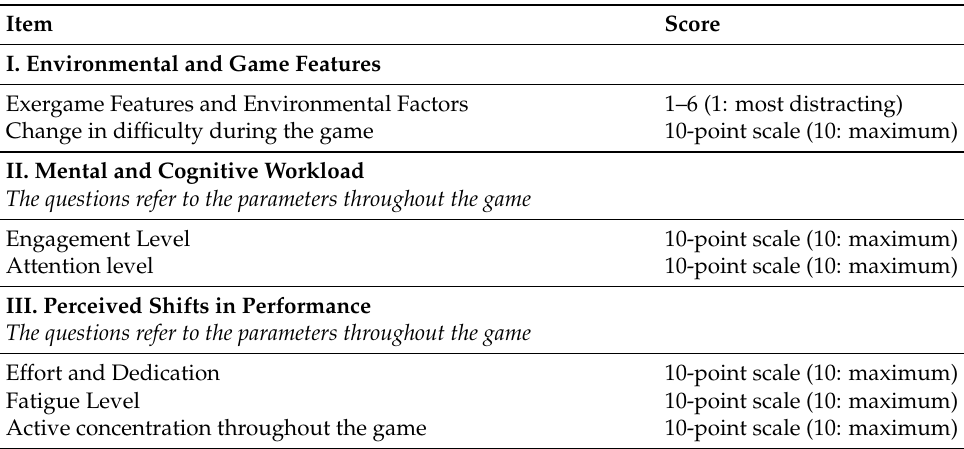
Table 3. TRESCA Questionnaire: items description and score